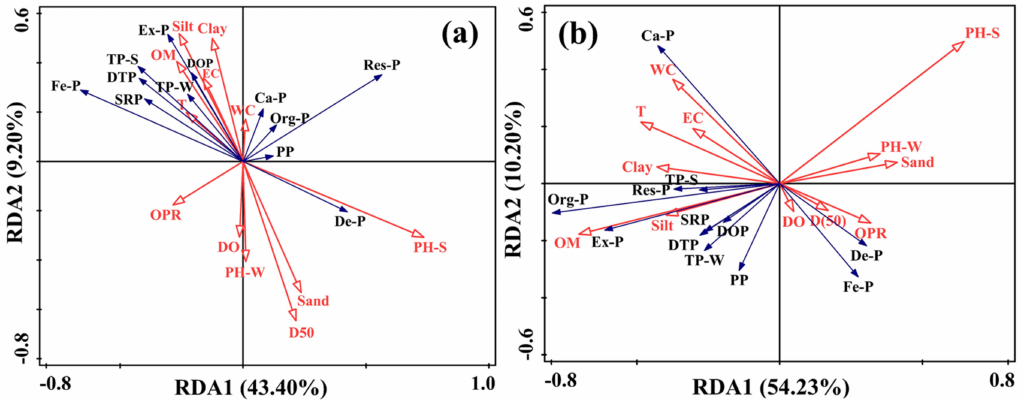
Figure 6. Redundancy analysis diagram between phosphorus fractions and environmental factors of water and sediments in the wet season ( a ) and dry season ( b ) in the Tuojiang River.